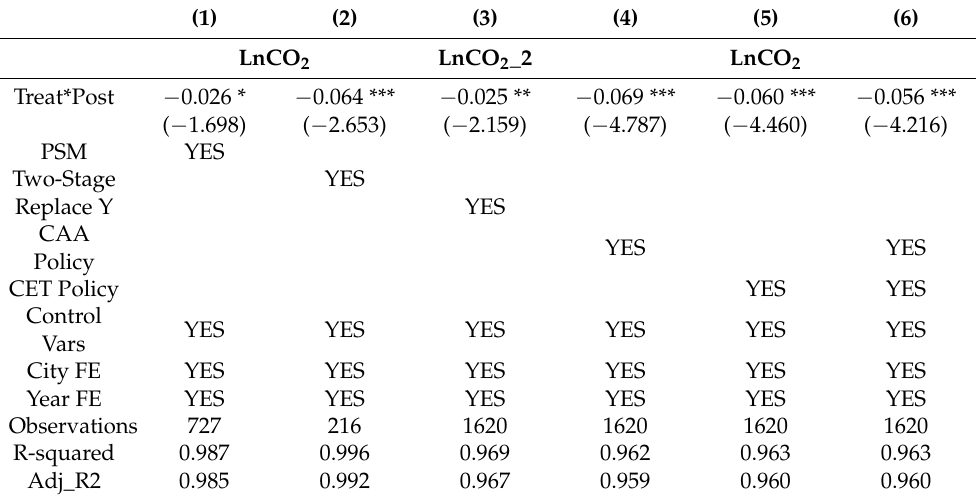
Table 4. Robustness check of the effect of city cluster policy on CO 2